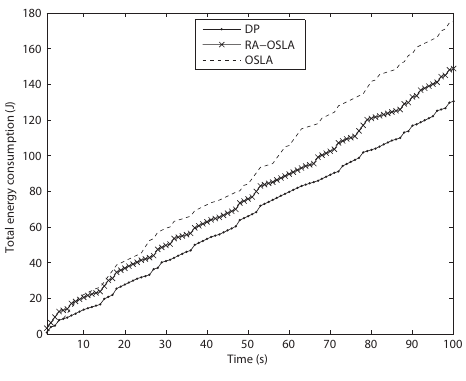
Figure 6. Variation of total energy consumption with time obtained by OSLA, RA-OSLA and